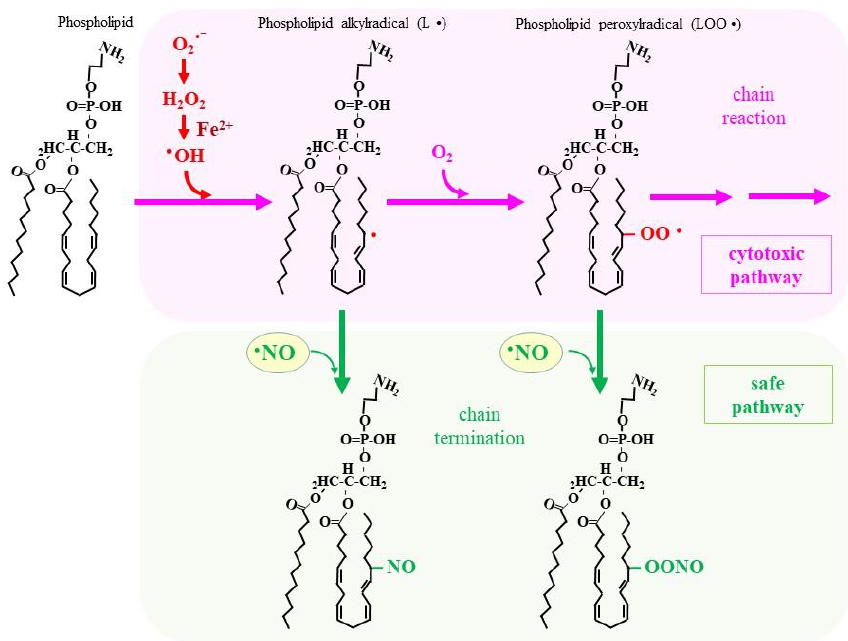
Figure 3. •NO suppresses ferroptosis by terminating the radical chain reaction of phospholipid